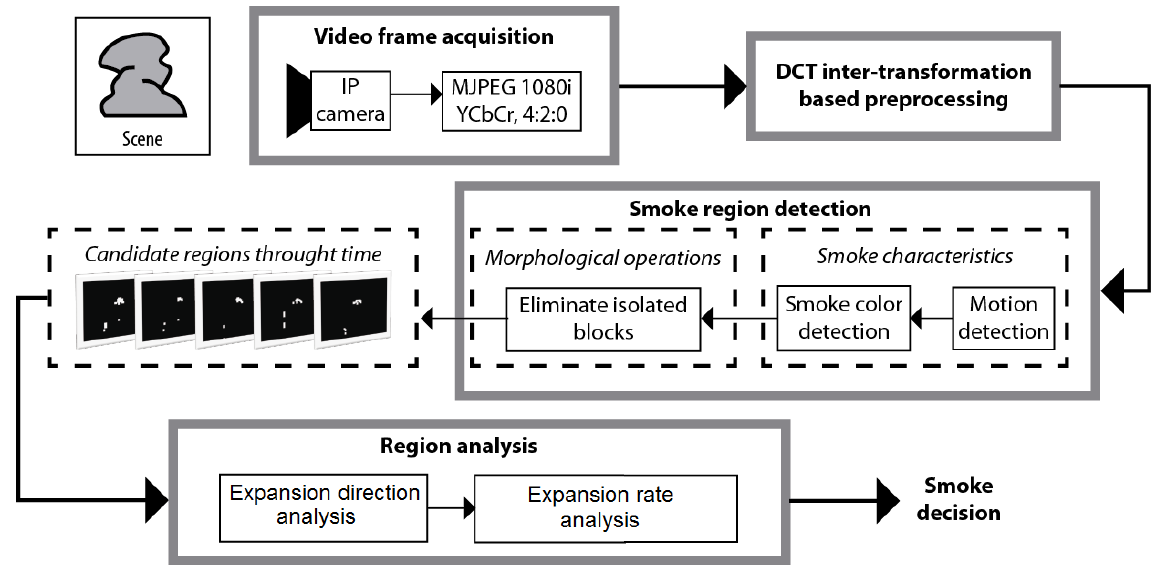
Figure 1. Block diagram of the proposed smoke detection